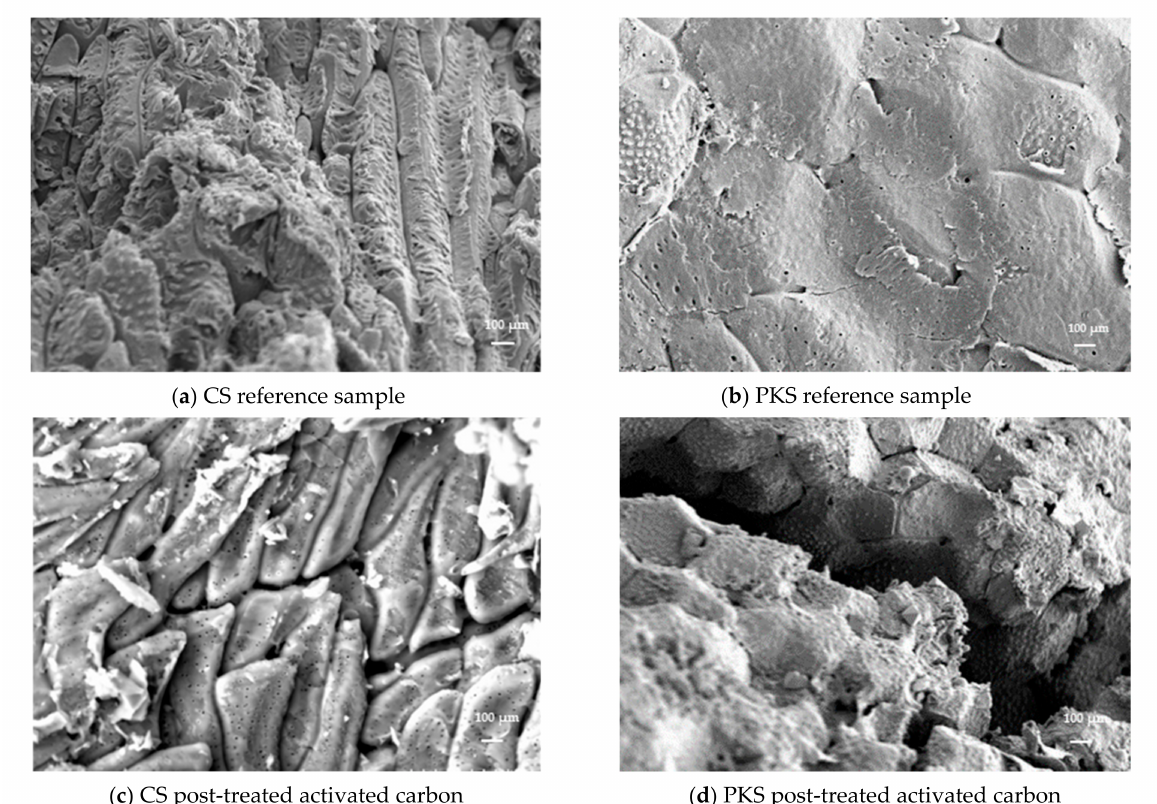
Figure 4. Scanning electron micrographs of ( a , b ) activated carbon prepared at 700 ◦ C for 75 min and ( c , d ) activated carbon (700 ◦ C, 75 min) post-treated with 25% NaOH at 1000 ×